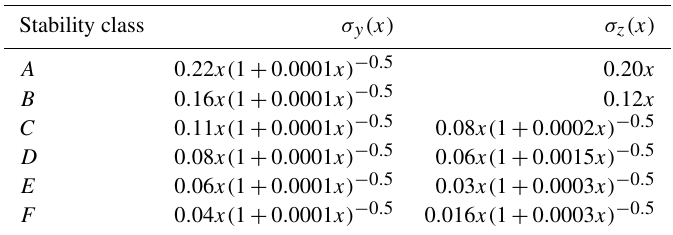
Table 4. Atmospheric dispersion parameters σ y and σ z for different stability classes in dependence of distance ( x ) from source in metres. For intermediate cases such as A − B the average of both values has been taken (Briggs, 1973).